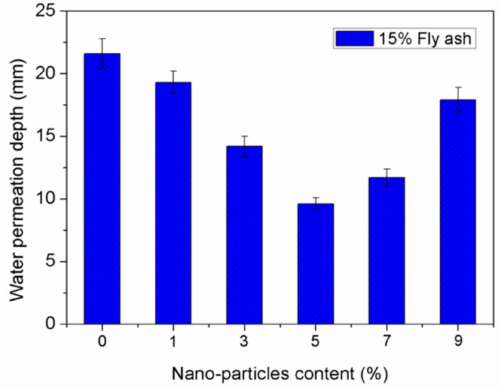
Figure 6. E ff ect of nano-silica dosage on the cracks number of concrete samples. Reprinted with permission from [84]. Copyright © 2019, MDPI AG.